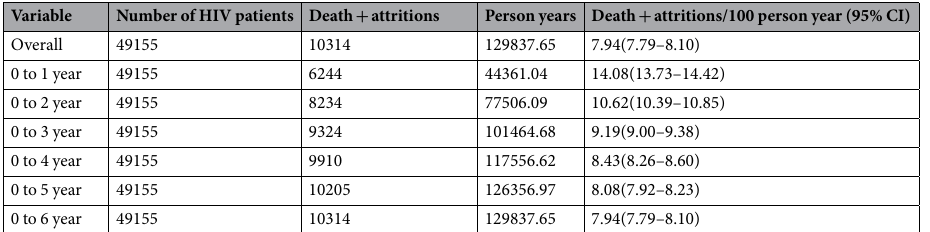
Table 4. Dearth + attrition rates in HIV-infected patients who started ART between 2010 and 2015 in Guangxi, China, by year post-ART initiation.